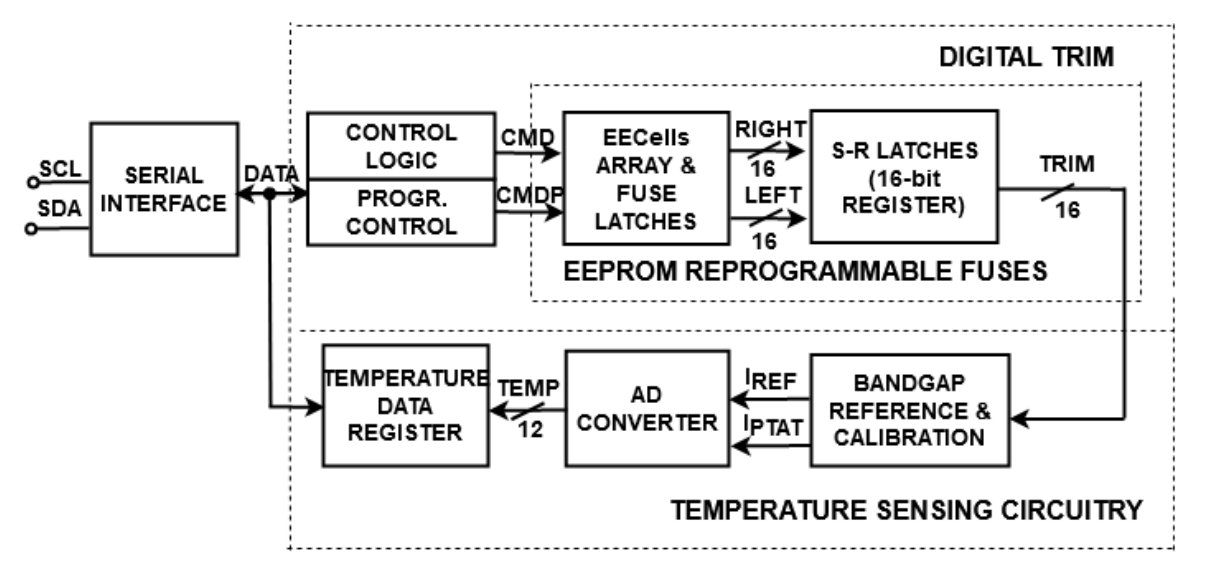
Figure 3. Block schematic of digital temperature sensor (DTS) [1].